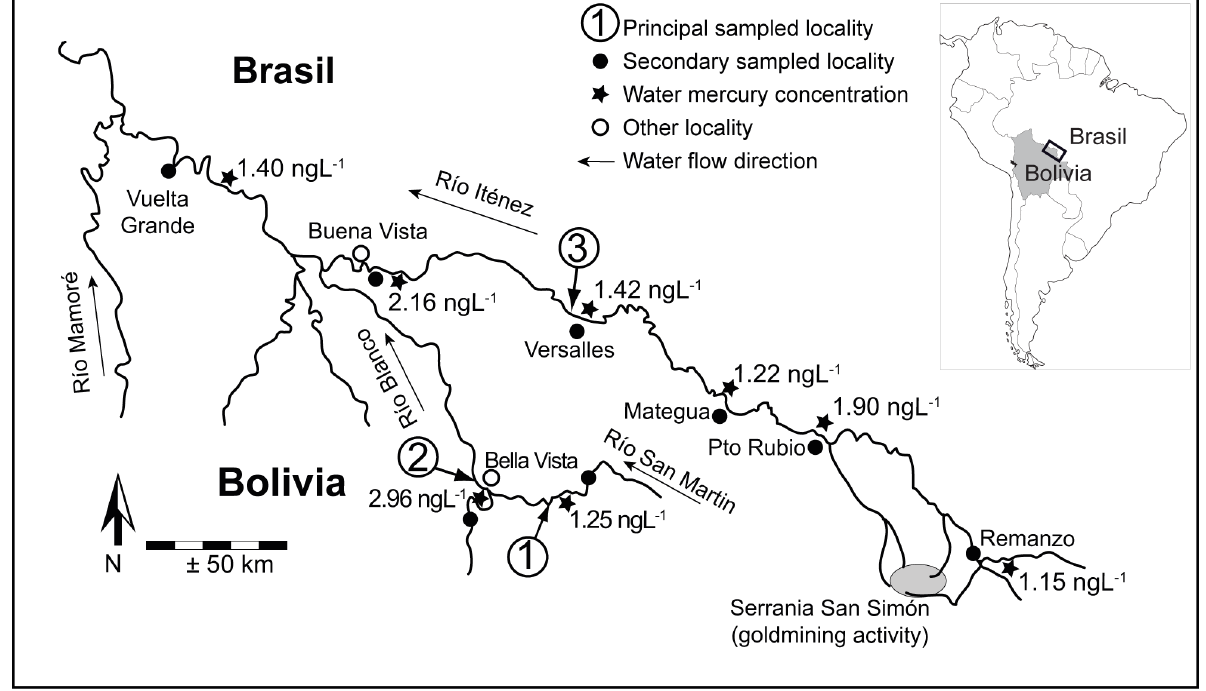
Figure 1. Hydrological map of the Bolivian part of the Ite´nez basin. Sampling locations (black point) and water mercury concentrations (star) are indicated. The principal sampled locations were: 1- San Martı´n River; 2- Blanco River; 3- Ite´nez River. (Redrawn from [13]).